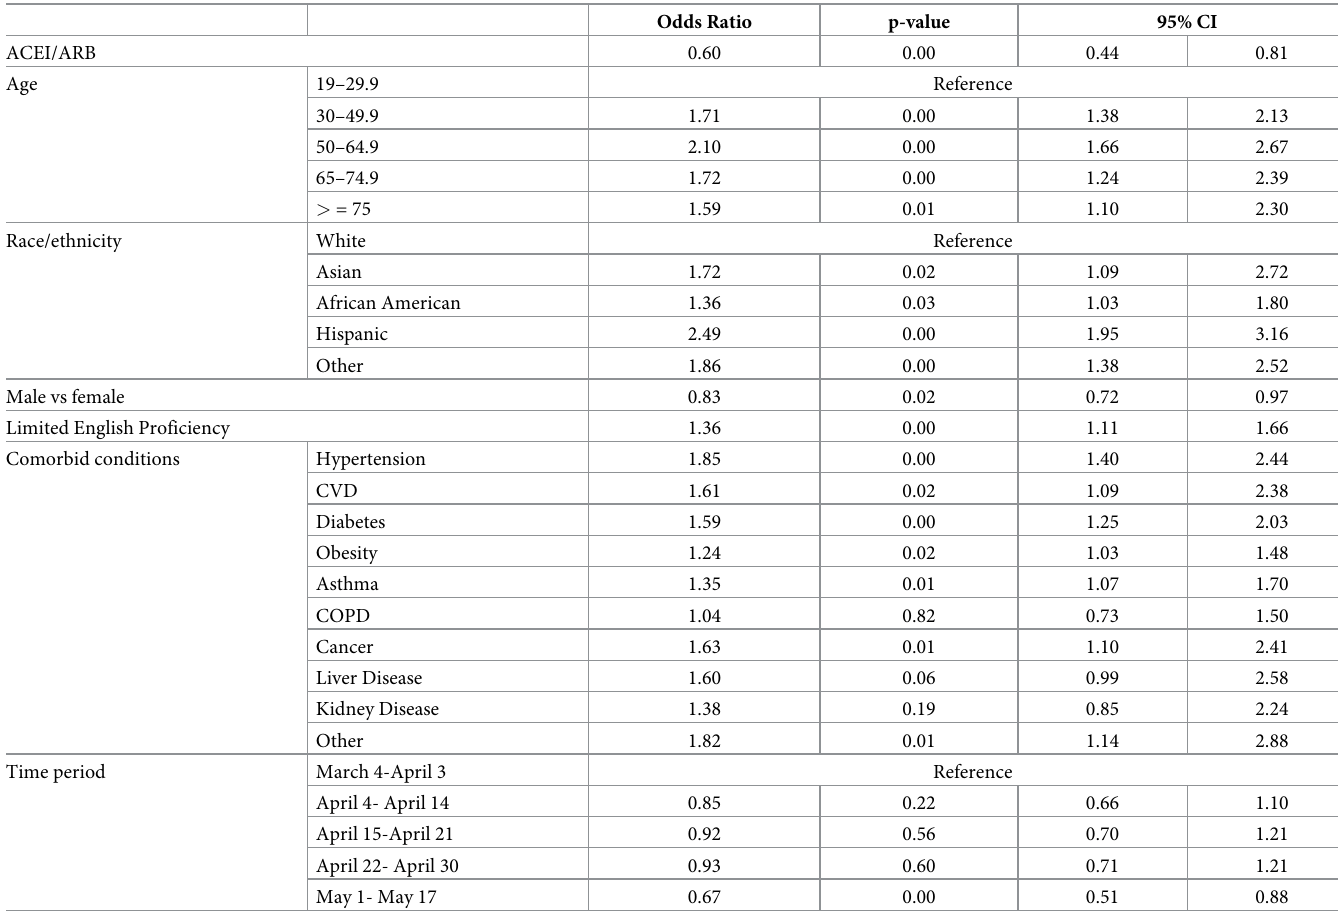
Table 2. Associations between ACEI/ARB Use and COVID-19 infection among household contacts of patients with COVID-19.